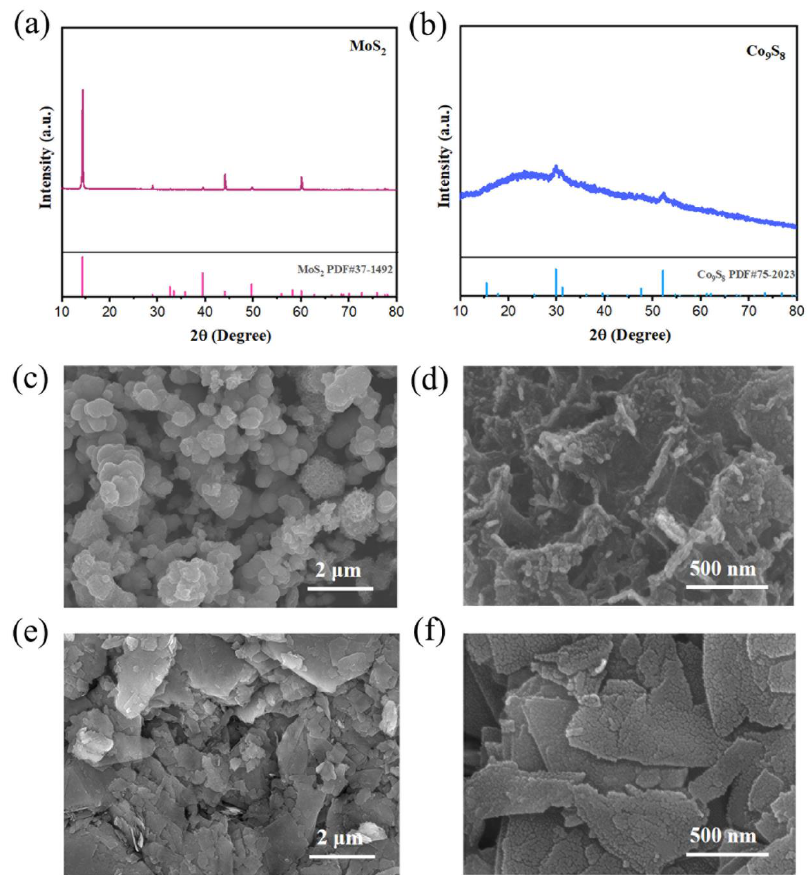
Figure 5. ( a ) XRD pattern of MoS 2 ; ( b ) XRD pattern of Co 9 S 8 ; ( c , d ) SEM images of MoS 2 with different scales; ( e , f ) SEM images of Co 9 S 8 with different